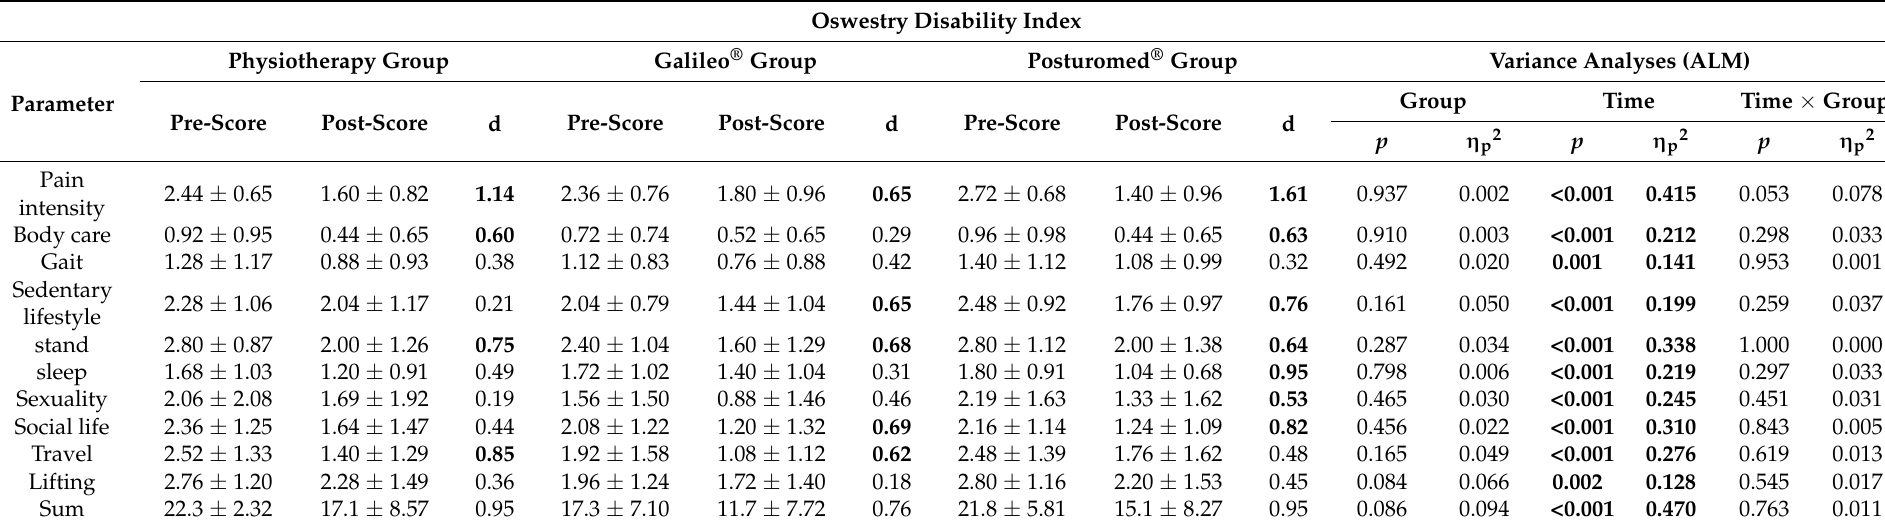
Table 2. Descriptive group comparison (mean ± SD) using the Oswestry Disability